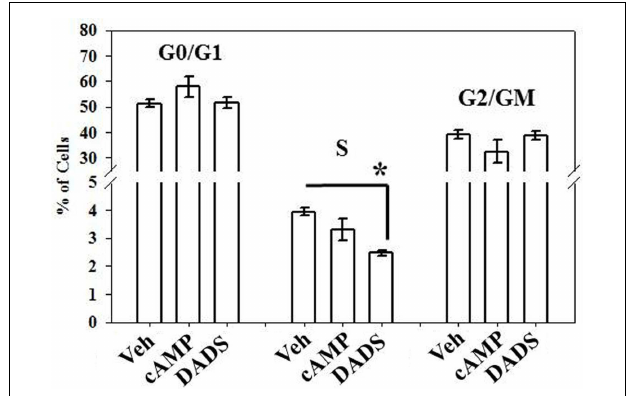
FIGURE 3 | Effects of 8Br-cAMP and DADS on 10% FBS-stimulated VSMC cell cycle progression. Using flow cytometry after 16h incubation, a 40% reduction in the percentage of cells in the S-phase was observed in the presence of DADS (50 µ M) with no significant changes in the G0/G1 or G2/M phases compared with vehicle controls. Data are mean ± SEM with an n = 3. Student–Newman–Keuls method for multiple comparisons following one-way ANOVA was used. * p < 0.05compared with vehicle